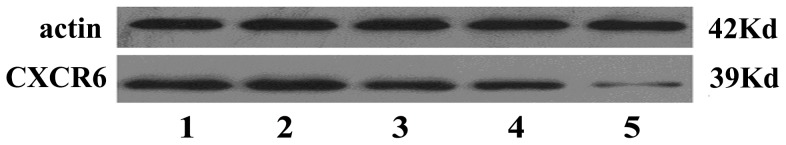
CXCR6 was effectively down-regulated by siRNA techonology.To silence the CXCR6 gene expression, we transfected A549 cells with phU6/GFP/Neo plasmid containing short hairpin RNA (shRNA) molecules targeted against CXCR6, with the usage of Lipofectamine 2000 (Invitrogen). The sequences for three shRNA oligonucleotides were: (CXCR6-2819-1): 5′-ctGAG GAC AAT TCC AAG ACT T-3′ (sense) and 5′-AAG TCT TGG AAT TGT CCT CAG-3′ (Anti-sense); (CXCR6-2820-2) 5′-ctCAC CAT GAT TGT CTG CTA T-3′ (sense) and 5′-ATA GCA GAC AAT CAT GGT GAG-3′ (Anti-sense); (CXCR6-2821-1) 5′-gcTTG CTC ATC TGG GTG ATA T-3′ (sense) and 5′-ATA TCA CCC AGA TGA GCA AGC-3′ (Anti-sense). Efficiency of RNA interference against CXCR6 was validated by western blot. It was shown in Fig. 7 that CXCR6 protein was substantially expressed in A549 cells (bank-control, without any treatment) and the RNA interference technology effectively inhibited CXCR6 expression in A549 cells. Lane 1: Blank-control; Lane 2: RNA-control; Lane 3: CXCR6 shRNA-(2821-1); Lane 4: CXCR6 shRNA-(2820-2); Lane 5: CXCR6 shRNA-(2819-1).